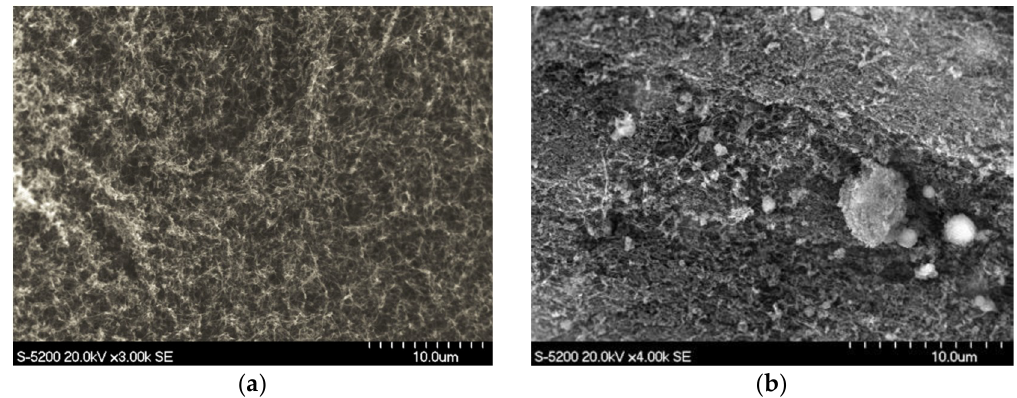
Figure 17. SEM images of BNNT nanomaterials from ( a ) BNNT, LLC, and ( b ) BNNano.